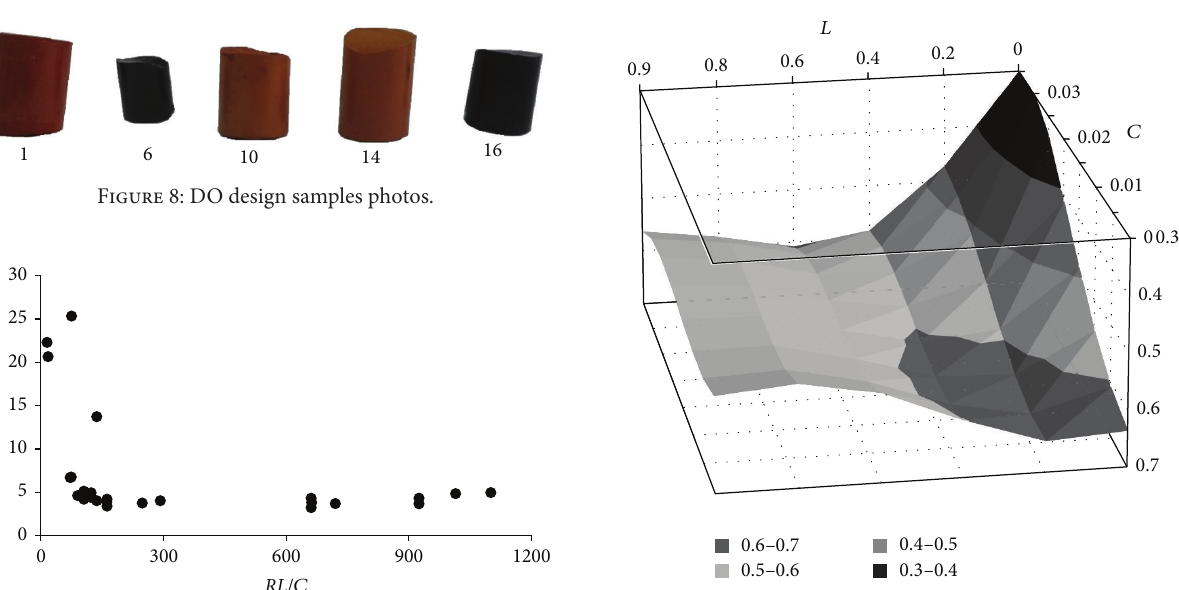
Figure 9: Radial shrinkage versus 𝑅𝐿/𝐶 in both designs, when 𝑅/𝐹 mass ratio is around 1.6.